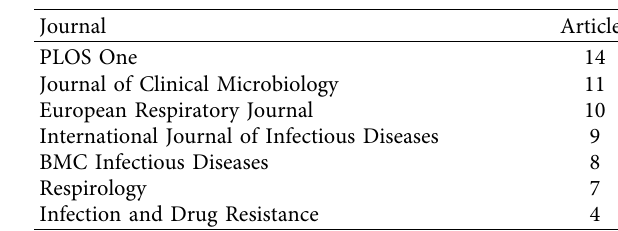
Figure 1: The Preferred Reporting Items for Systematic Reviews and Meta-Analyses (PRISMA) for this study. Table 1: Top 7 journals that published articles on the GeneXpert in